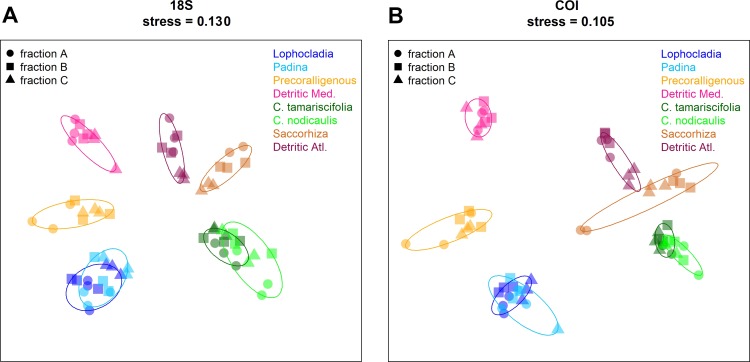
Non-metric multidimensionalscaling (nmMDS) representation of the samples using the Bray–Curtis coefficient.(A) 18S, (B) COI. Samples are symbol-coded for fraction and colour-coded for community. Stress of the final configurations is indicated.